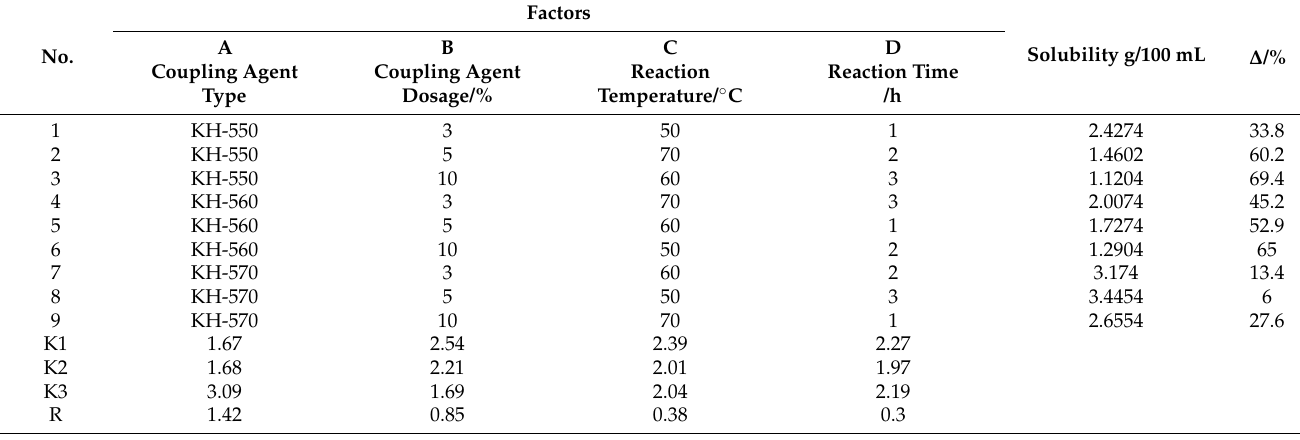
Table 4. Orthogonal design and results table.